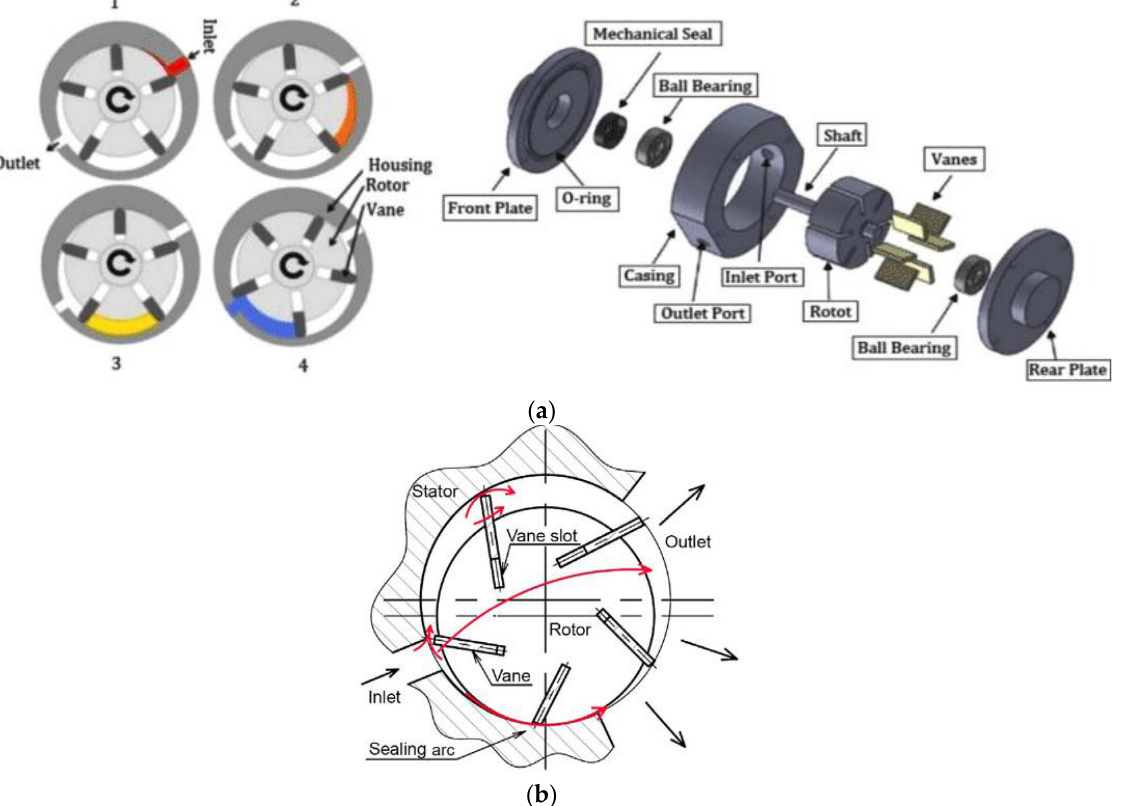
Figure 14. Two-phase vane expander, with principle of operation ( a ) [12] and leakage pathways ( b ) [59].